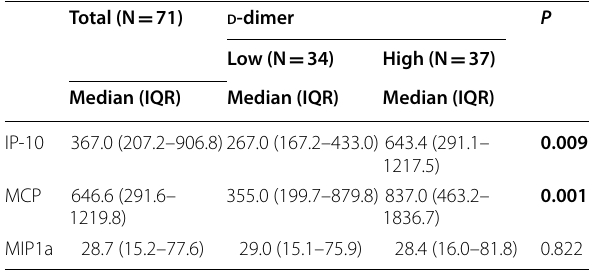
Bold indicates the statistically significant values ( P <